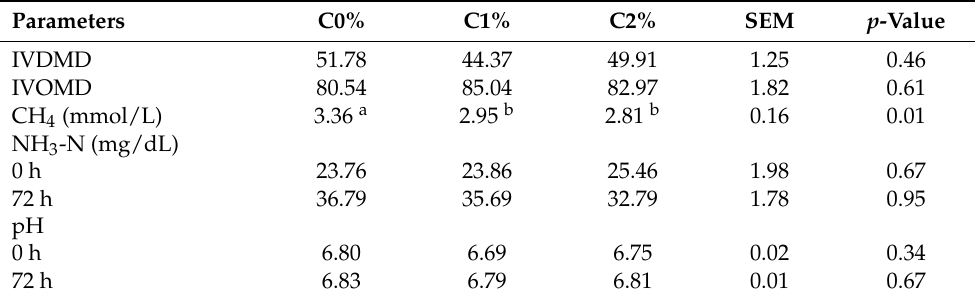
Table 4. Effect of variations among treatment diets on some fermentation characteristics.